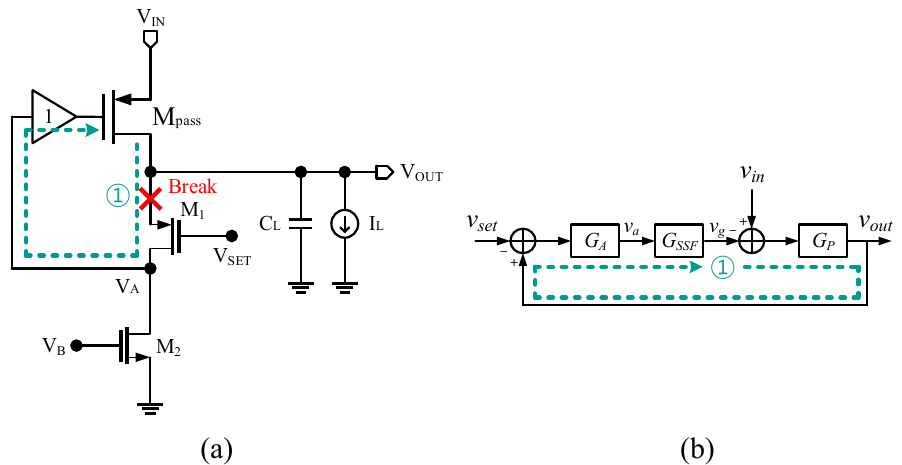
Figure 2. ( a ) FVF LDO without loop 2 and ( b ) its small-signal block diagram.